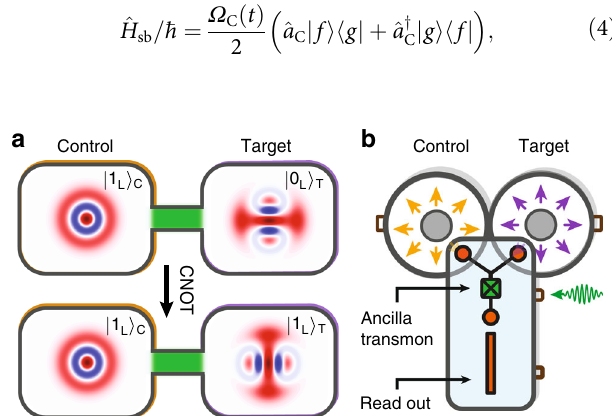
Fig. 1 Experimental implementation of an entangling gate between multiphoton qubits encoded in two cavities. a Example of the CNOT operation. In the initial state, illustrated by the Wigner distributions in the top panel, the control qubit is in 1 L j i , and the target qubit in 0 L j i (as C T de fi ned in Eqs. (1) and (2)). Under the action of the CNOT gate, enabled by a nonlinear coupling between the cavities (in green), the target state at the output (bottom panel) is inverted to 1 L j i . b Sketch of the device, which is T housed inside an aluminum box, and cooled down to 20 mK. The control and target qubits are encoded in photon states of the fundamental modes (yellow and purple arrows) of two coaxial cavities with frequencies ω C /2 π = 4.22 GHz and ω π = 5.45 GHz, respectively. The ancilla transmon T /2 ( ω q /2 π = 4.79 GHz) has two coupling pads (orange circles) that overlap with the cavity fi elds. Cavity-ancilla interaction is achieved by application of a frequency-matched RF drive (green arrow) to the coupling pin near the Josephson junction (marked by X). The ancilla also serves to prepare and read out the cavity state, and is measured by its dispersive coupling to a stripline readout resonator (orange rectangle). More details on this device can be found in Supplementary Note 1 and ref.